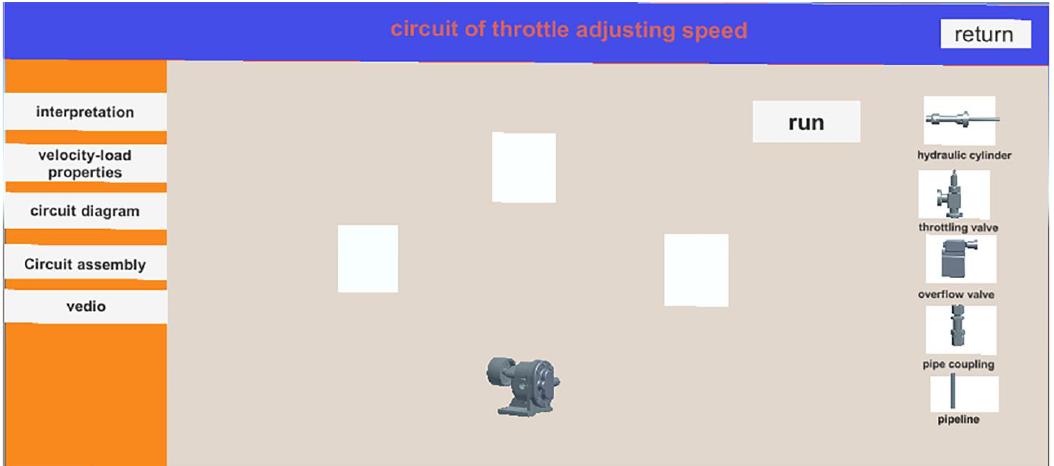
Figure 11. The experimental interface for building a throttle speed control loop.